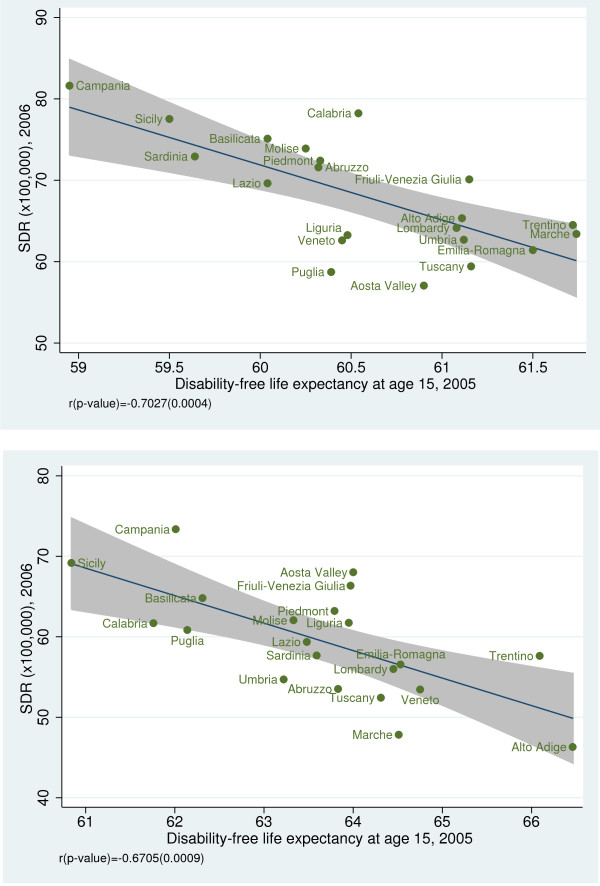
a.Amenable mortality vs. disability-free life expectancy at age 15 (males). Data source: Indagine Istat su condizioni di salute e ricorso ai servizi sanitari 2004–2005 [15]. b. Amenable mortality vs. disability-free life expectancy at age 15 (females). Data source: Indagine Istat su condizioni di salute e ricorso ai servizi sanitari 2004–2005 [15].